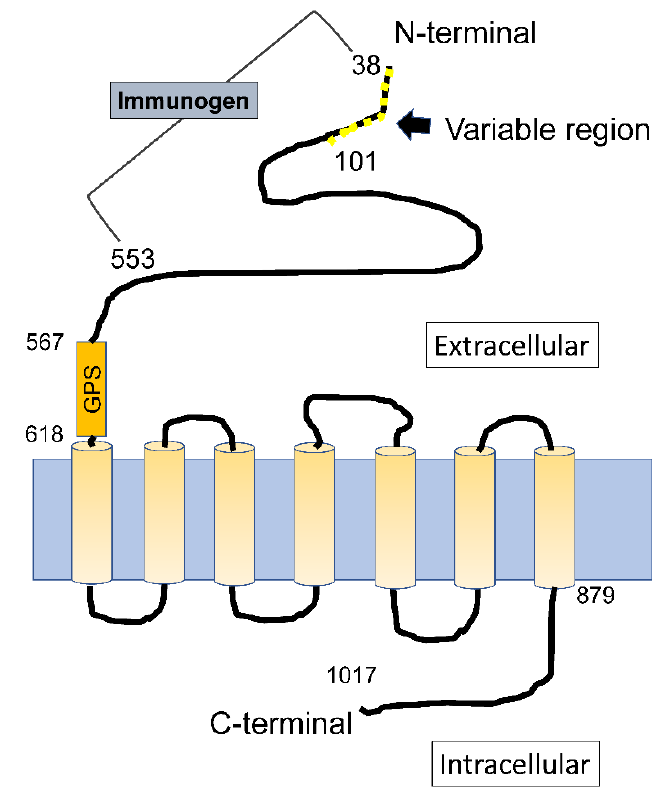
Figure 3. The sequence comprising amino acids 38–101 is called the variable region. Selective splicing occurs intensively, and diversity is observed mainly in this area. Isoform 1, full length; isoform 2, lacking amino acids 65–67; isoform 3, lacking amino acids 51–66; isoform 4, lacking amino acids 88–101; isoform 5, lacking amino acids 52–75; isoform 6, amino acids 52–101 sequence change; isoform 7, amino acids 52–101 sequence change; isoform 9, lacking amino acids 906–956; and isoform 10, lacking amino acids 51–66, 88–101, 474–562. Modified from Kirchhoff et al., 2006.